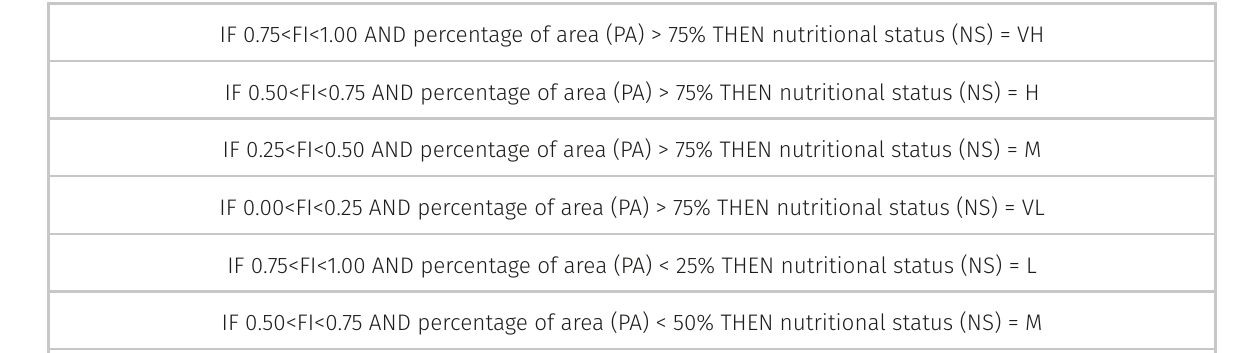
Table II. Rules of inference to the rubber tree nutritional